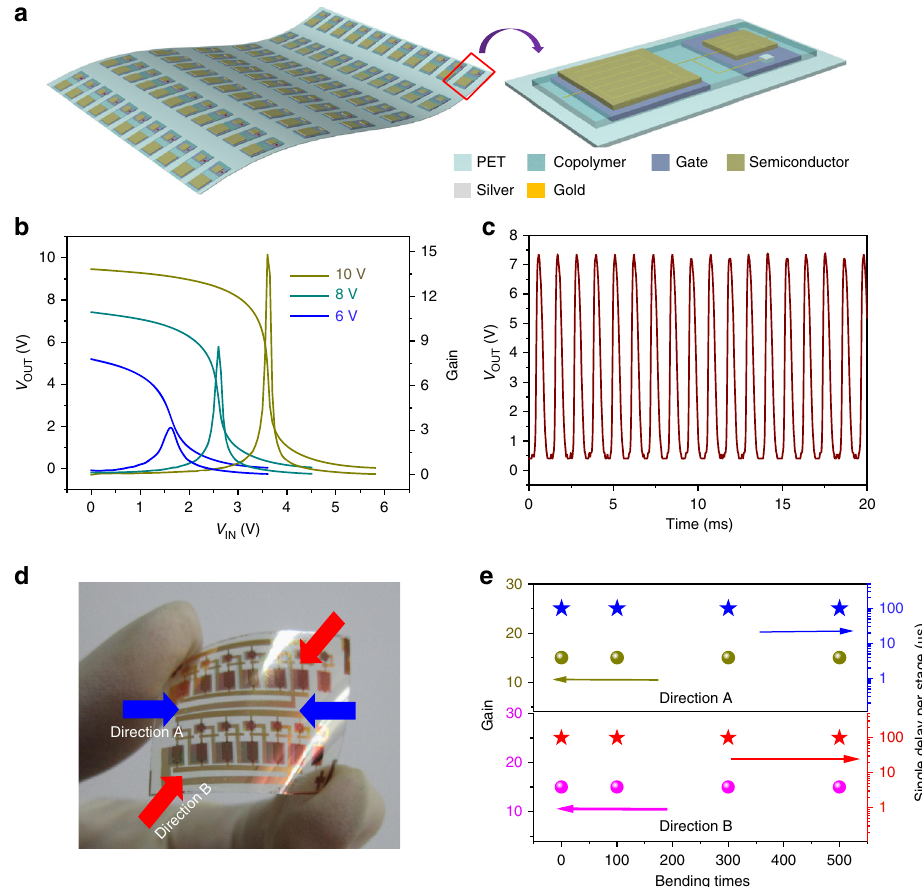
Fig. 7 Performance of fl exible circuits. a Flexible invertor arrays and the structure of a unipolar inverter. b Output voltage and signal gain as a function of input voltage with supply voltage of 6, 8, and 10 V. c Five-stage ring oscillators and their representative electrical characteristic based on pentacene. d The bending test (direction A and direction B) of the circuits. e Plots of gain and single delay per stage versus bending